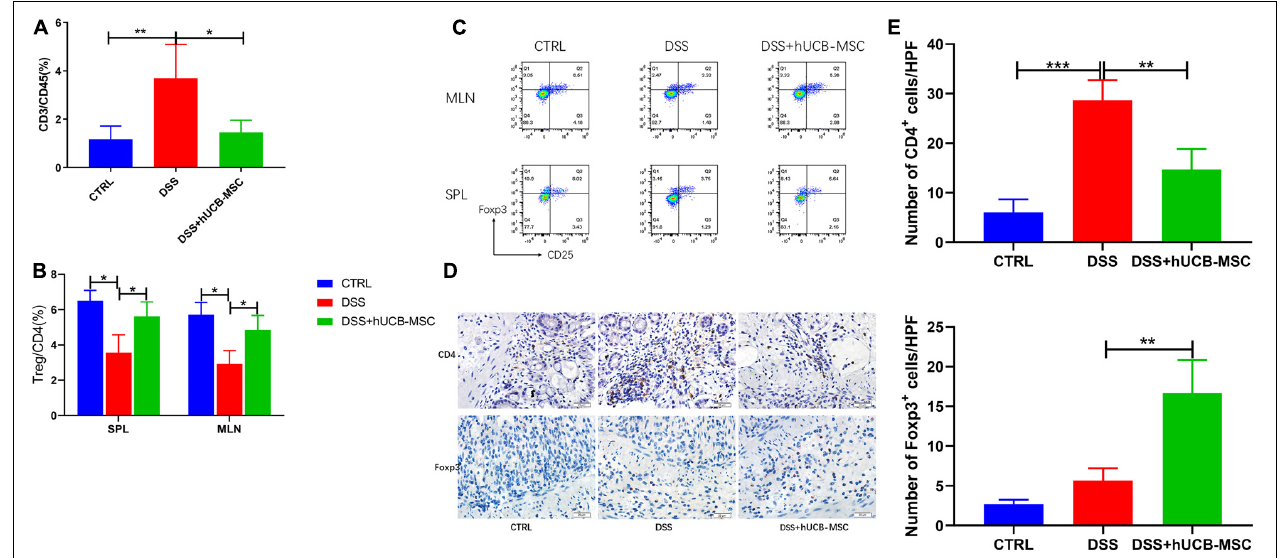
FIGURE 6 | hUCB-MSC treatment reduced T cell infiltration in colon and induced Tregs in MLN, SPL, and colon. (A) Evaluation of T cell (%) infiltration to the colon. Flow cytometry analysis of CD3 + T cells gated in CD45 + population. (B,C) MLNs and splenocytes were analyzed for expression of Treg (staining for Foxp3 and CD25 in gated CD4 + T cells) via flow cytometry. * p < 0.05 and ** p < 0.01. (D) Immunohistochemical staining (10 × 40) of CD4 + cells and Foxp3 + cells in colon tissues were showed. (E) Statistical results of immunohistochemical staining images for CD4 + cells and Foxp3 + cells. ** p < 0.01 and *** p <